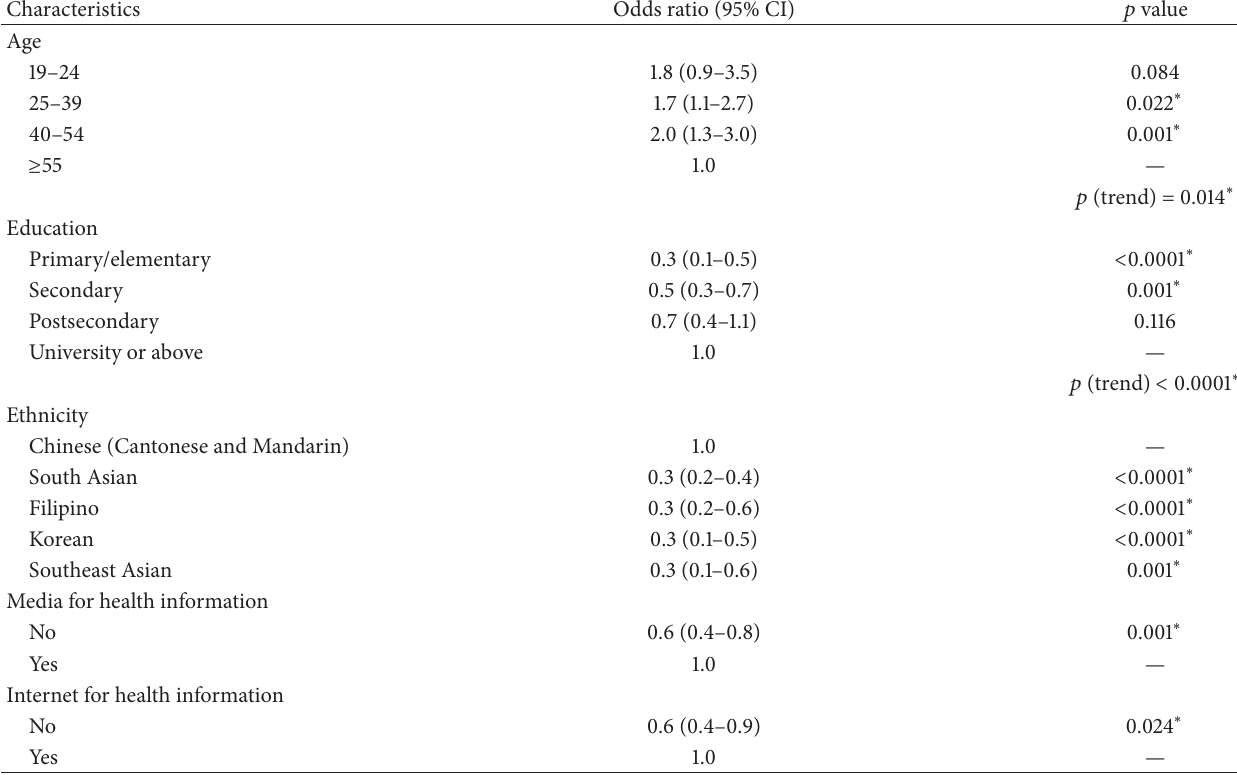
Table 4: Predictors of HBV knowledge from multivariate analysis.